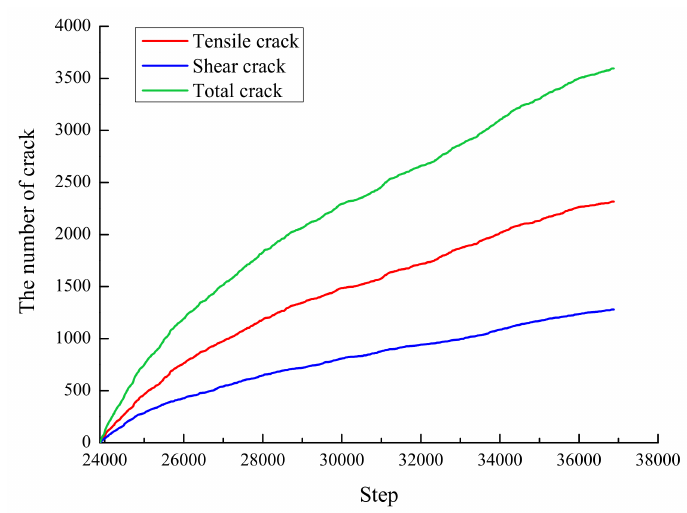
Figure 12. Slotting simulation results showing the number of cracks in the model under loading.